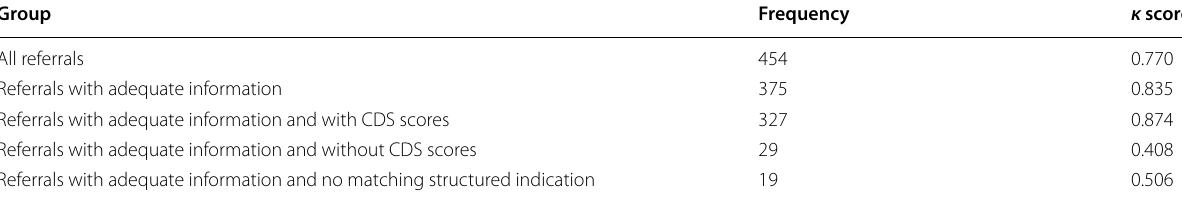
Table 1 Referral grouping and associated inter-rater agreement between the two human experts Group